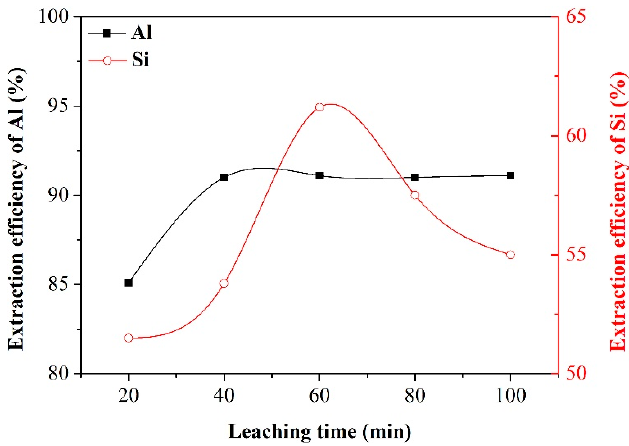
Figure 9. Effect of leaching time on the extraction efficiency of Al and Si. Figure 9. E ff ect of leaching time on the extraction e ffi ciency of Al and